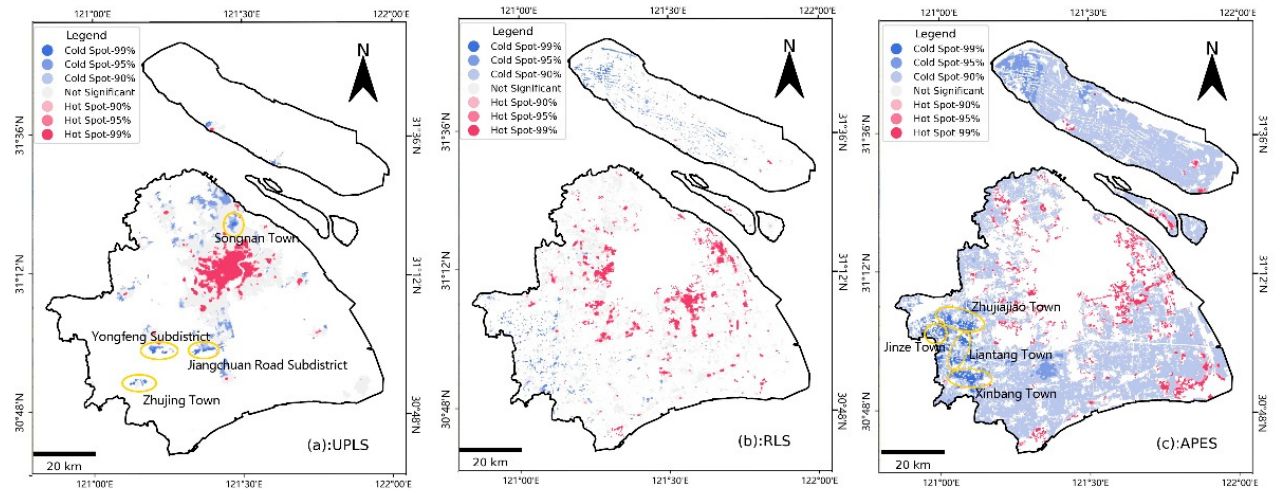
Figure 6. Space exploration results (1).